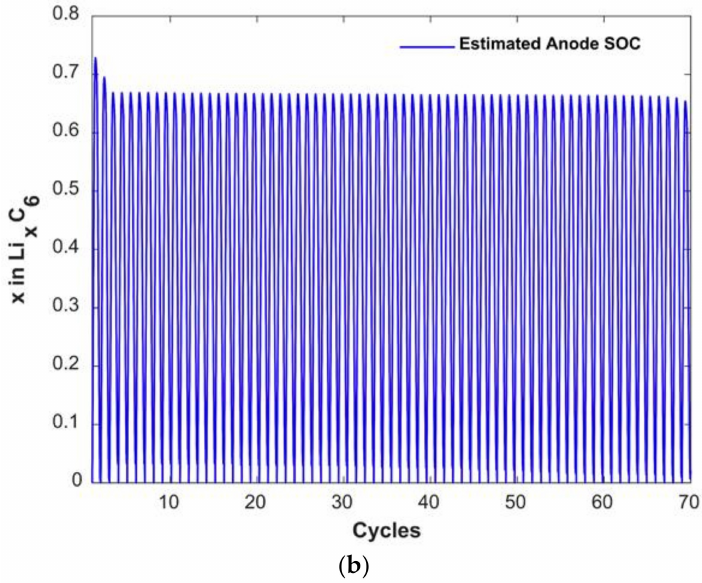
Figure 10. ( a ) Calculated anode capacity over charging cycles. ( b ) Estimated anode stoichiometric range (SOC).